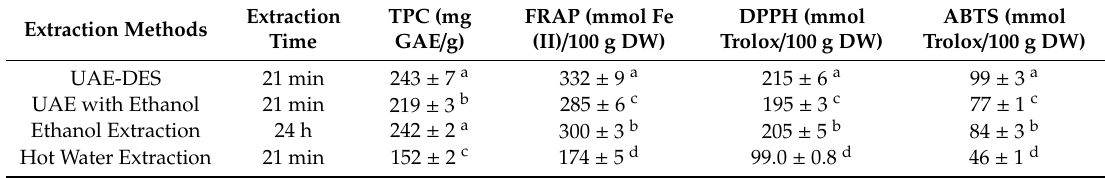
Table 5. TPC and antioxidant activity of the extracts obtained by di ff erent extraction methods. Extraction Methods